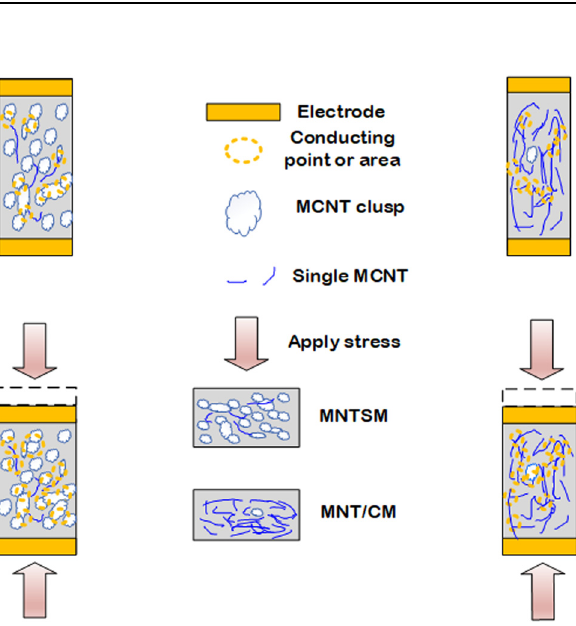
Figure 8: The conducting mechanism of MNTSM, MNT/CM under compressive